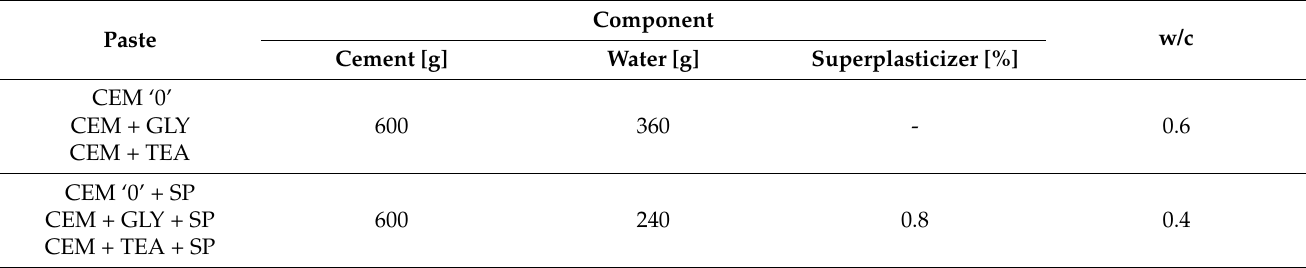
Table 4. Composition of pastes for rheological